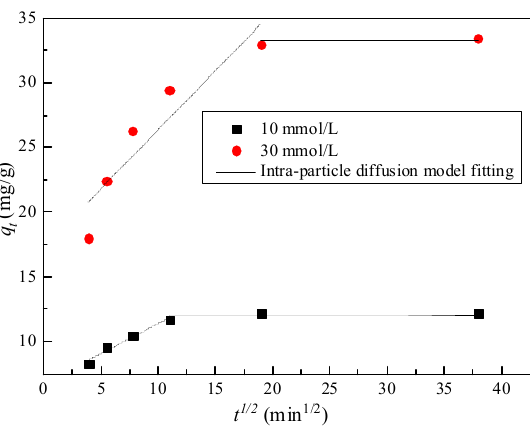
Figure 7. Pseudo second order model.